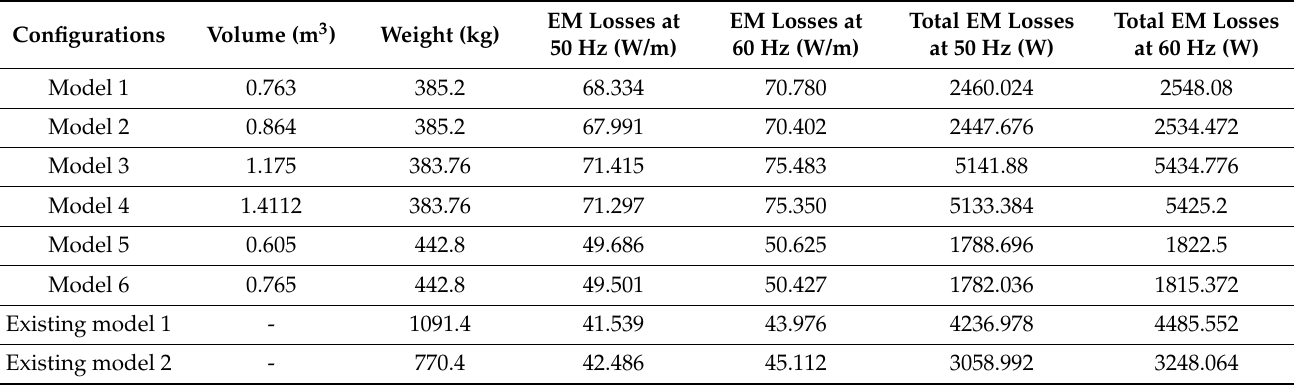
Table 11. Data for conduction of numerical